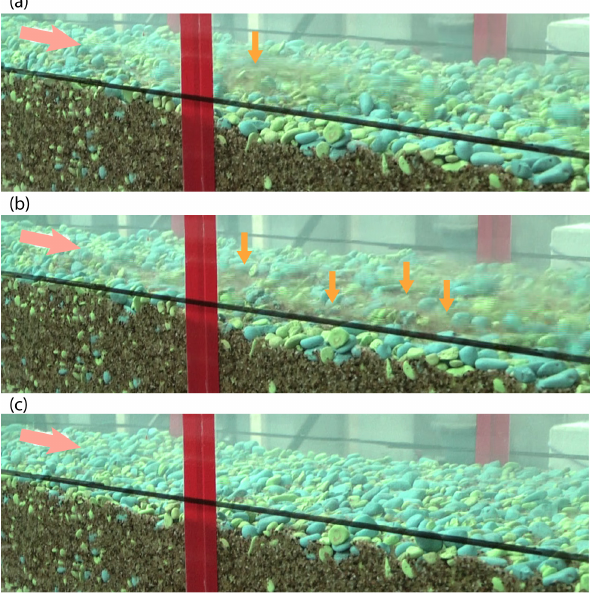
Figure 8. Armor breakup and reformation between Compartments 6 and 7: (a) initial local breakup, (b) widening of the breakup and exposure of the finer substrate, (c) reformation of the mobile armor. Flow is from left to right. Blurriness in images (a) and (b) indicates the entrainment of sand (orange arrows).